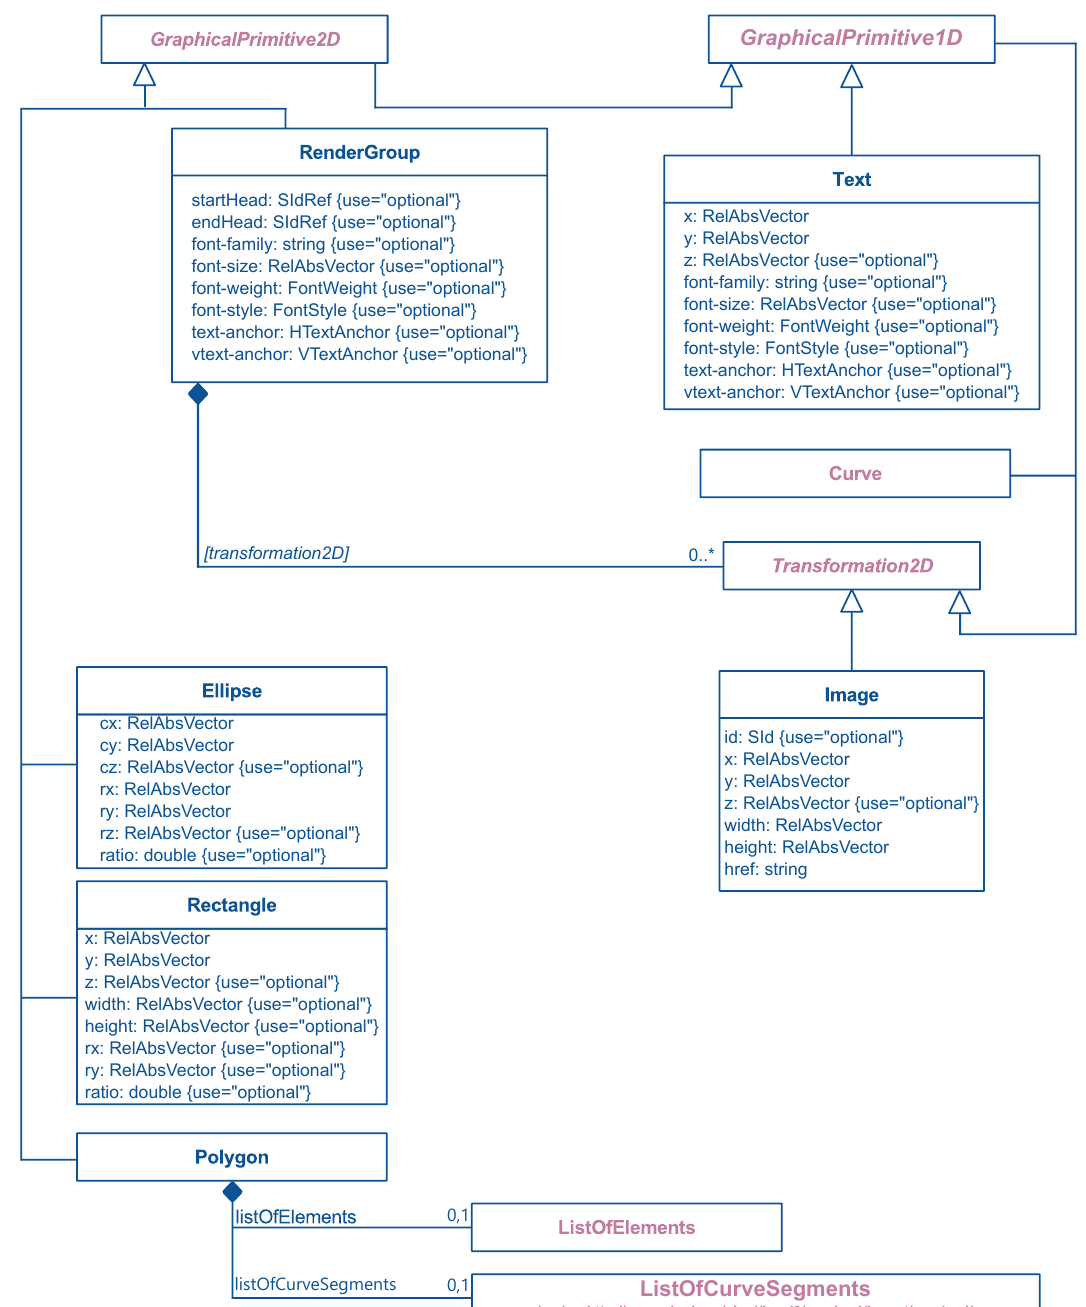
Figure 12: A UML representation of the graphical primitive classes for the Render package. See Section 1.4 for conven- tions related to this figure.